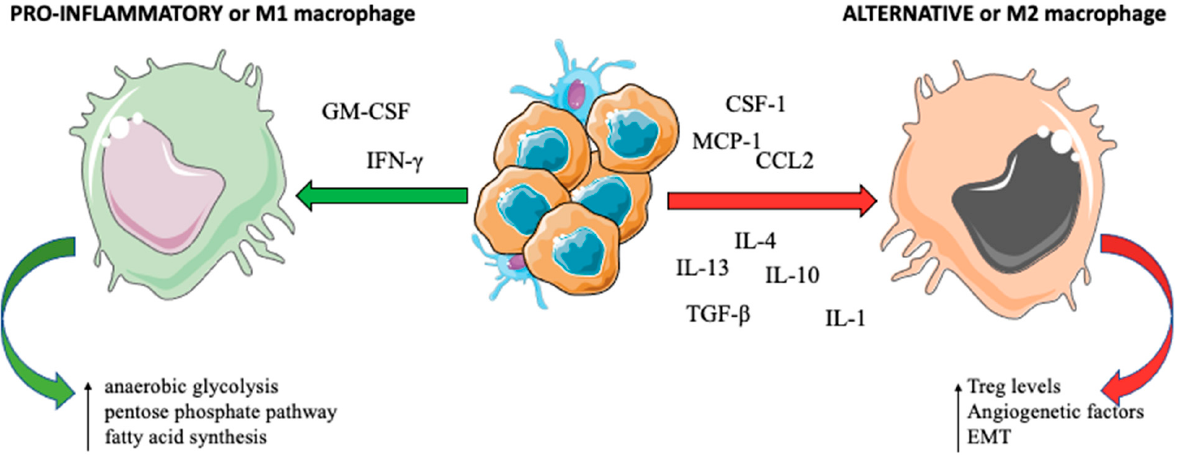
Figure 2. Cytokines and chemokines involved in macrophagic polarization. Tumoral and stromal cells secrete growth factors involved in monocyte attraction and macrophagic differentiation in M1 pro-inflammatory macrophages, with anti-tumor function, and M2 alternative macrophages, with pro-apoptotic